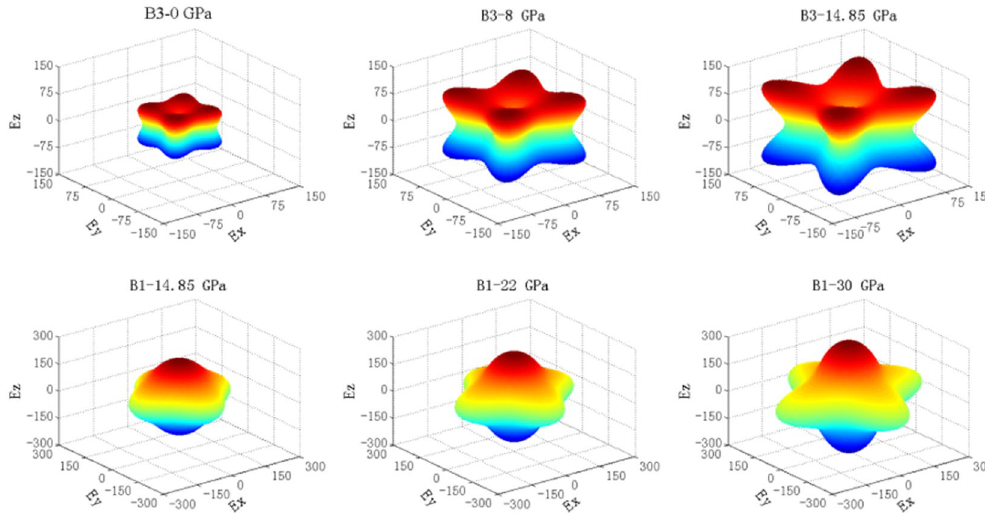
Figure 6. The surface construction of the Young’s modulus for both B3 and B1 phases of ZnSe (unit: